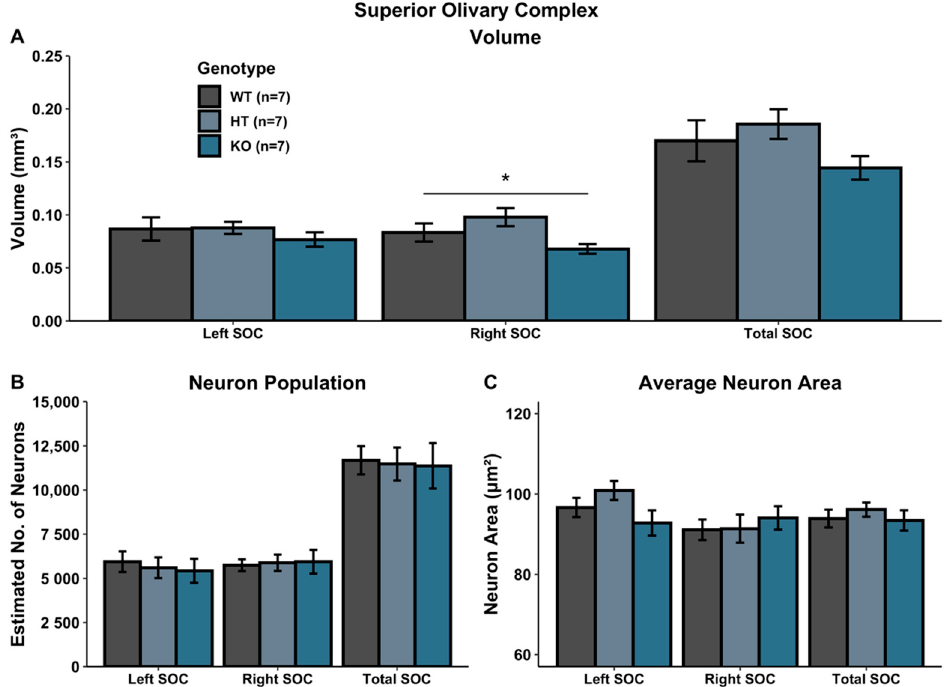
Figure 2. Histological assessment in SOC. ( A ) Volumetric analysis of left, right and total (left + right) SOC. Heterozygous Ush2a mutations increased the volume of the right SOC while homozygous Ush2a mutations reduced the volume of the right SOC. ( B , C ) There were no significant genotype differences in neuron population ( B ) or average neuron area ( C ). * p <